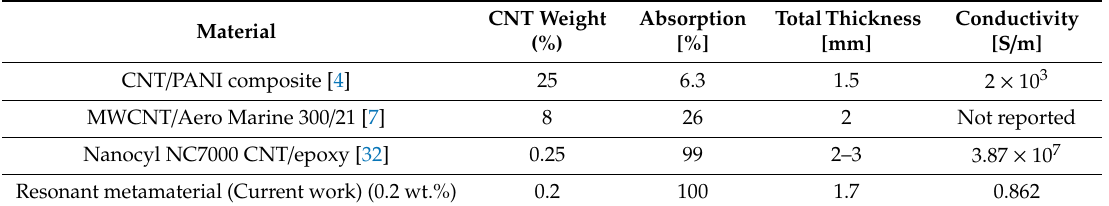
Table 2. Comparison of selected composite materials performance.